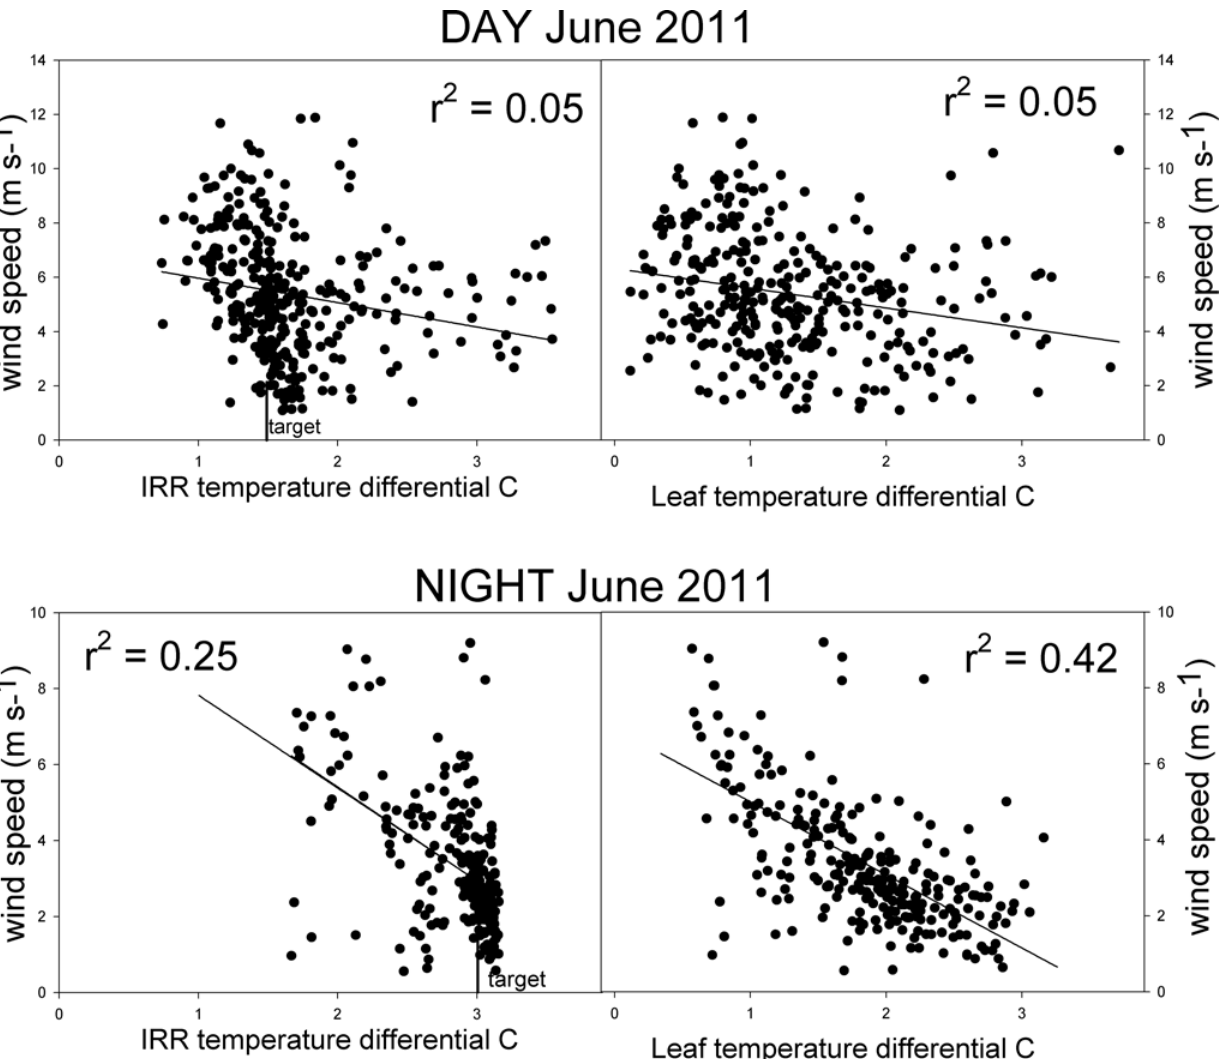
Figure 3. Effects of wind on performance of IR warming in T-FACE experimental plots. Graphs show hourly wind speed vs. infra-red radiometer and leaf temperature differentials (warmed minus control) of T-FACE plots during the DAY and NIGHT (1.5 and 3.0°C target differentials) during June of 2011 at the Prairie Heating and CO 2 Enrichment